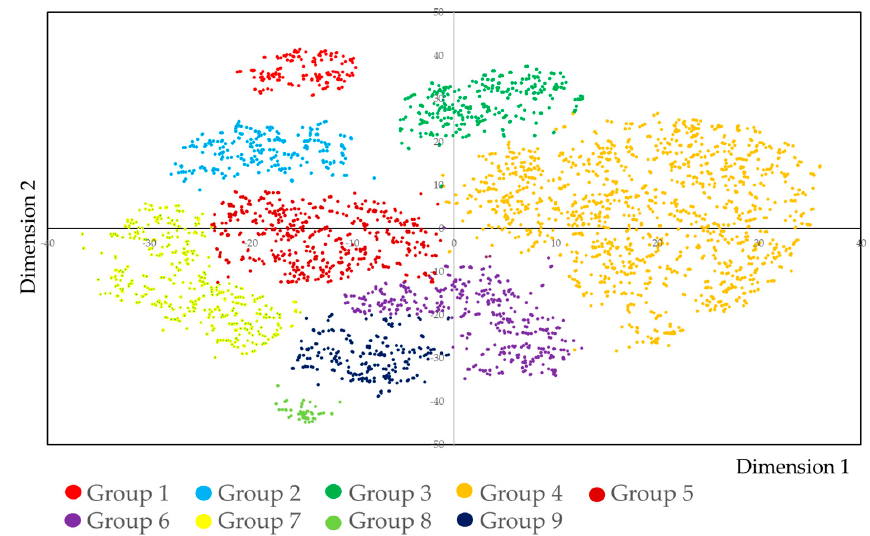
Figure 2. t-distributed stochastic neighbor embedding (tSNE) plot by ability, calculated by item response theory (IRT) analysis of the daily work-related tasks of dental hygienists. Ability indicates the weighted number of implemented daily work-related tasks. Dental hygienists participating in this study were clearly classified by the implementation of daily work-related tasks. tSNE: t-distributed stochastic neighbor embedding. Table 1. Characteristics of the groups by tSNE analysis.